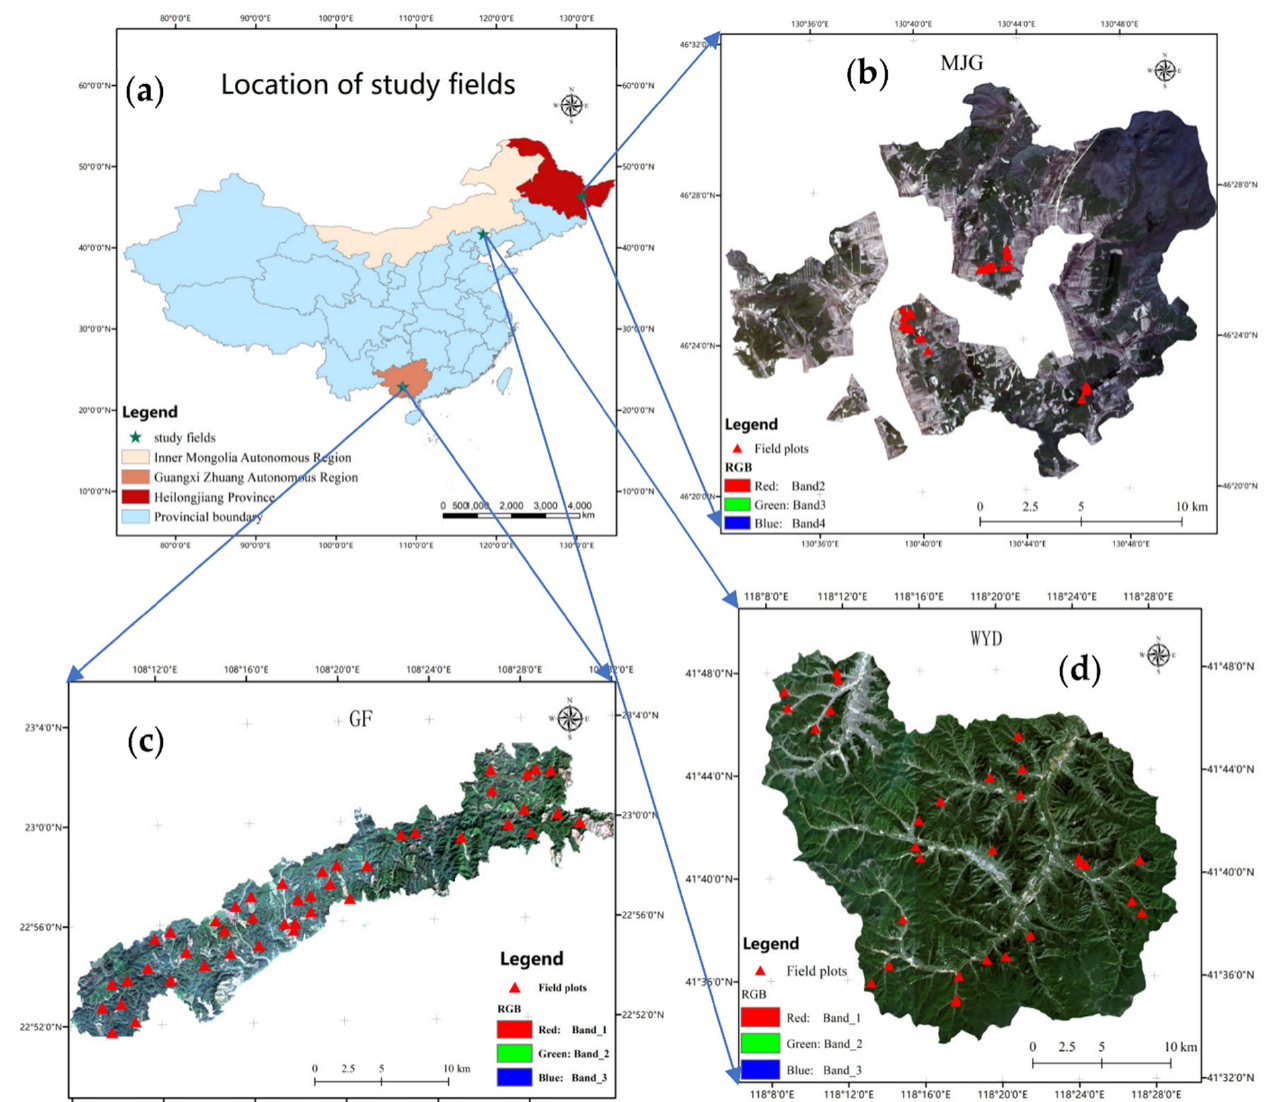
Figure 1. ( a ) The location of the study area and the field plots: ( b ) Mengjiagang Forest Farm (MJG); ( c ) Gaofeng Forest Farm (GF); ( d ) Wangyedian Forest Farm (WYD).